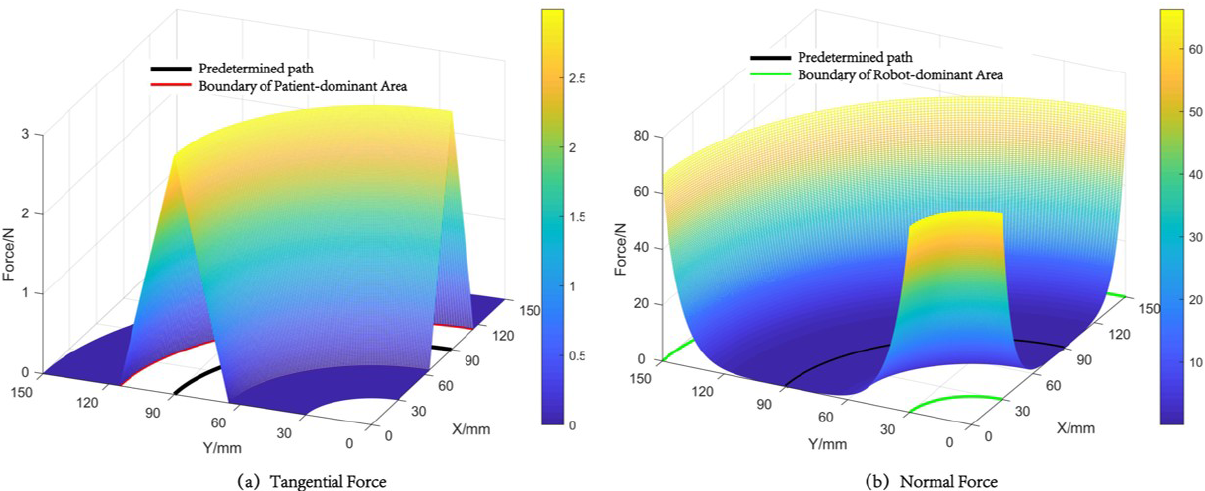
Figure 2. Variation characteristics of the tangential force (a) and normal force (b) around the predetermined path.